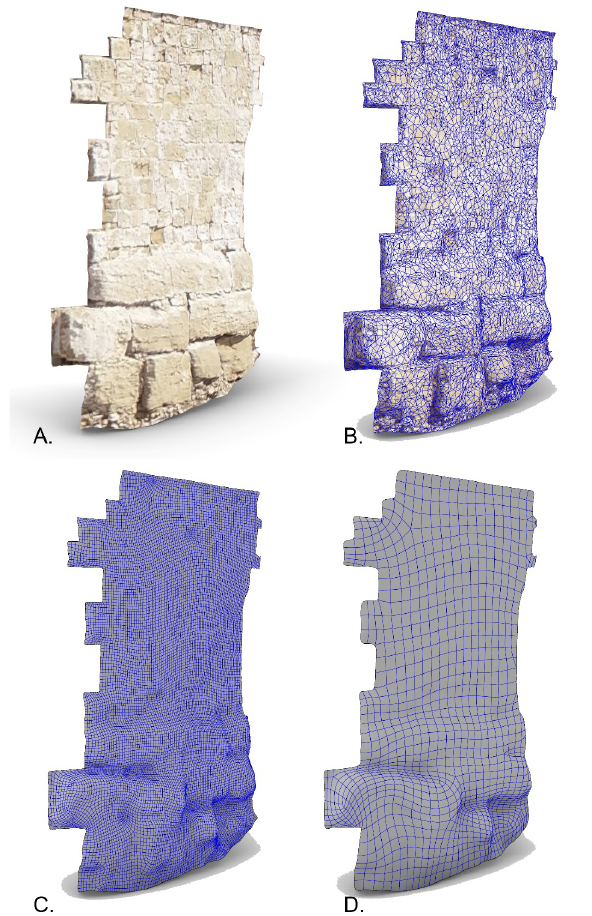
Figure 8. Paphos Castle seaside wall that shows two wall types.